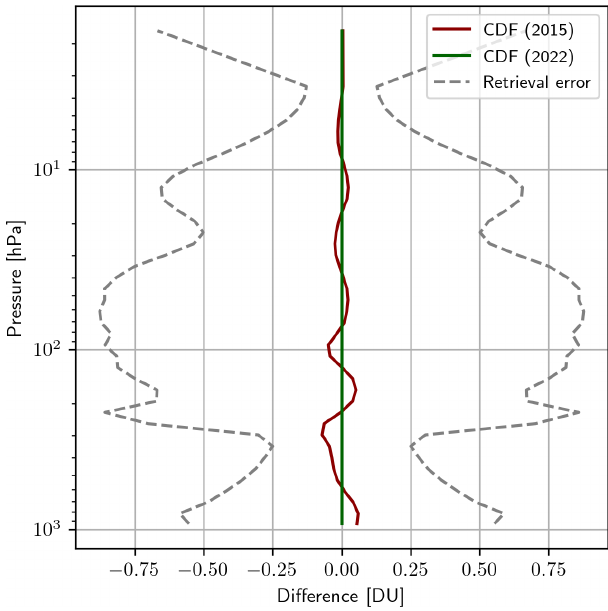
Figure 3. Results of the consistency test with CDF (2015) consid- ering only the 5, 6 and 7 largest eigenvalues in the calculation of the generalized inverse matrix of S n i .